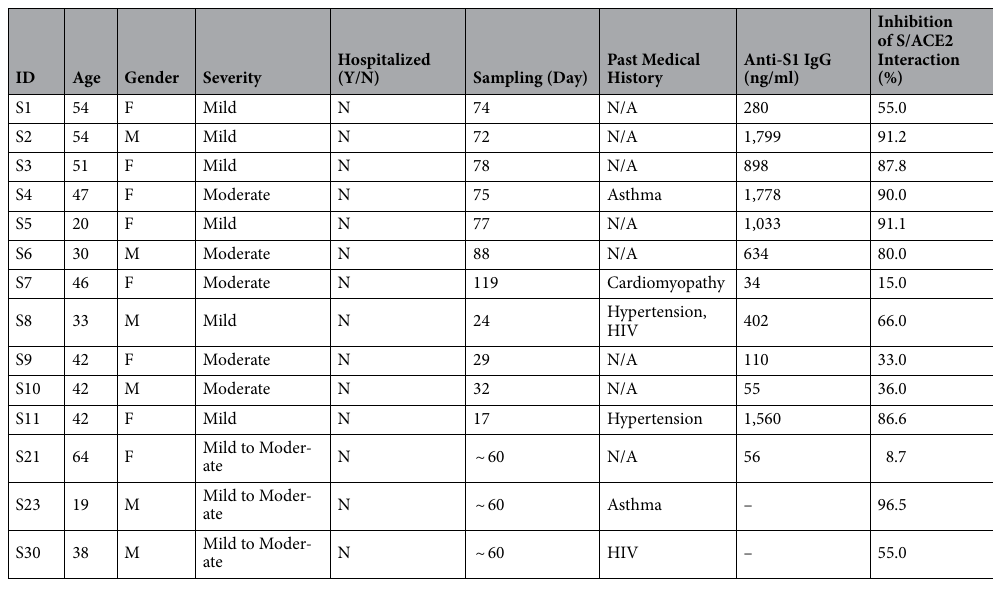
Table 1. The characteristics of COVID-19